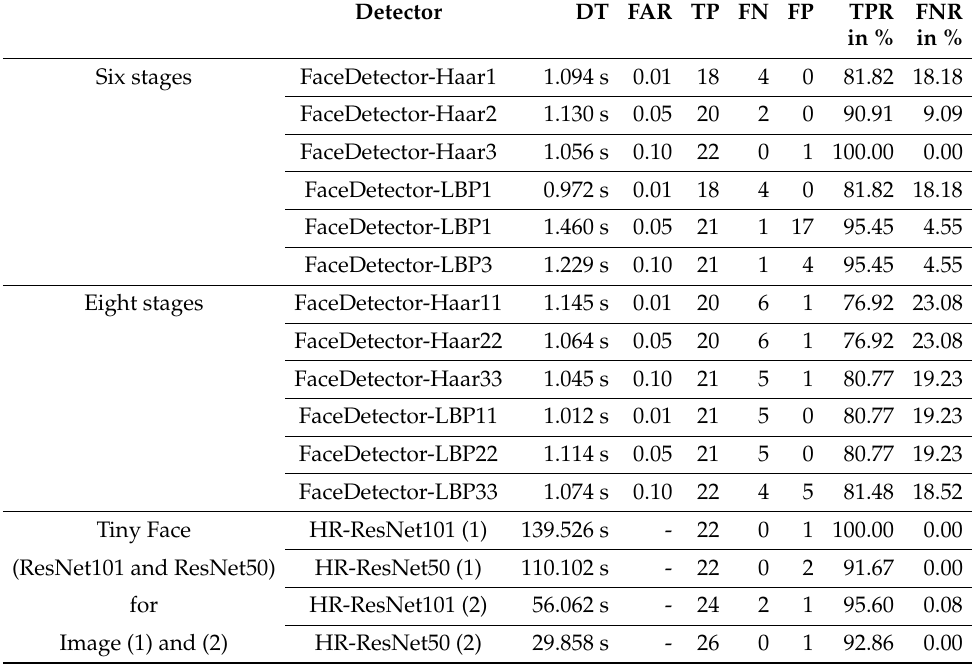
Table 3. The performance of Haar-like, LBP for 6 and 8 stages compared to deep learning ResNet101 and ResNet50 pretrained